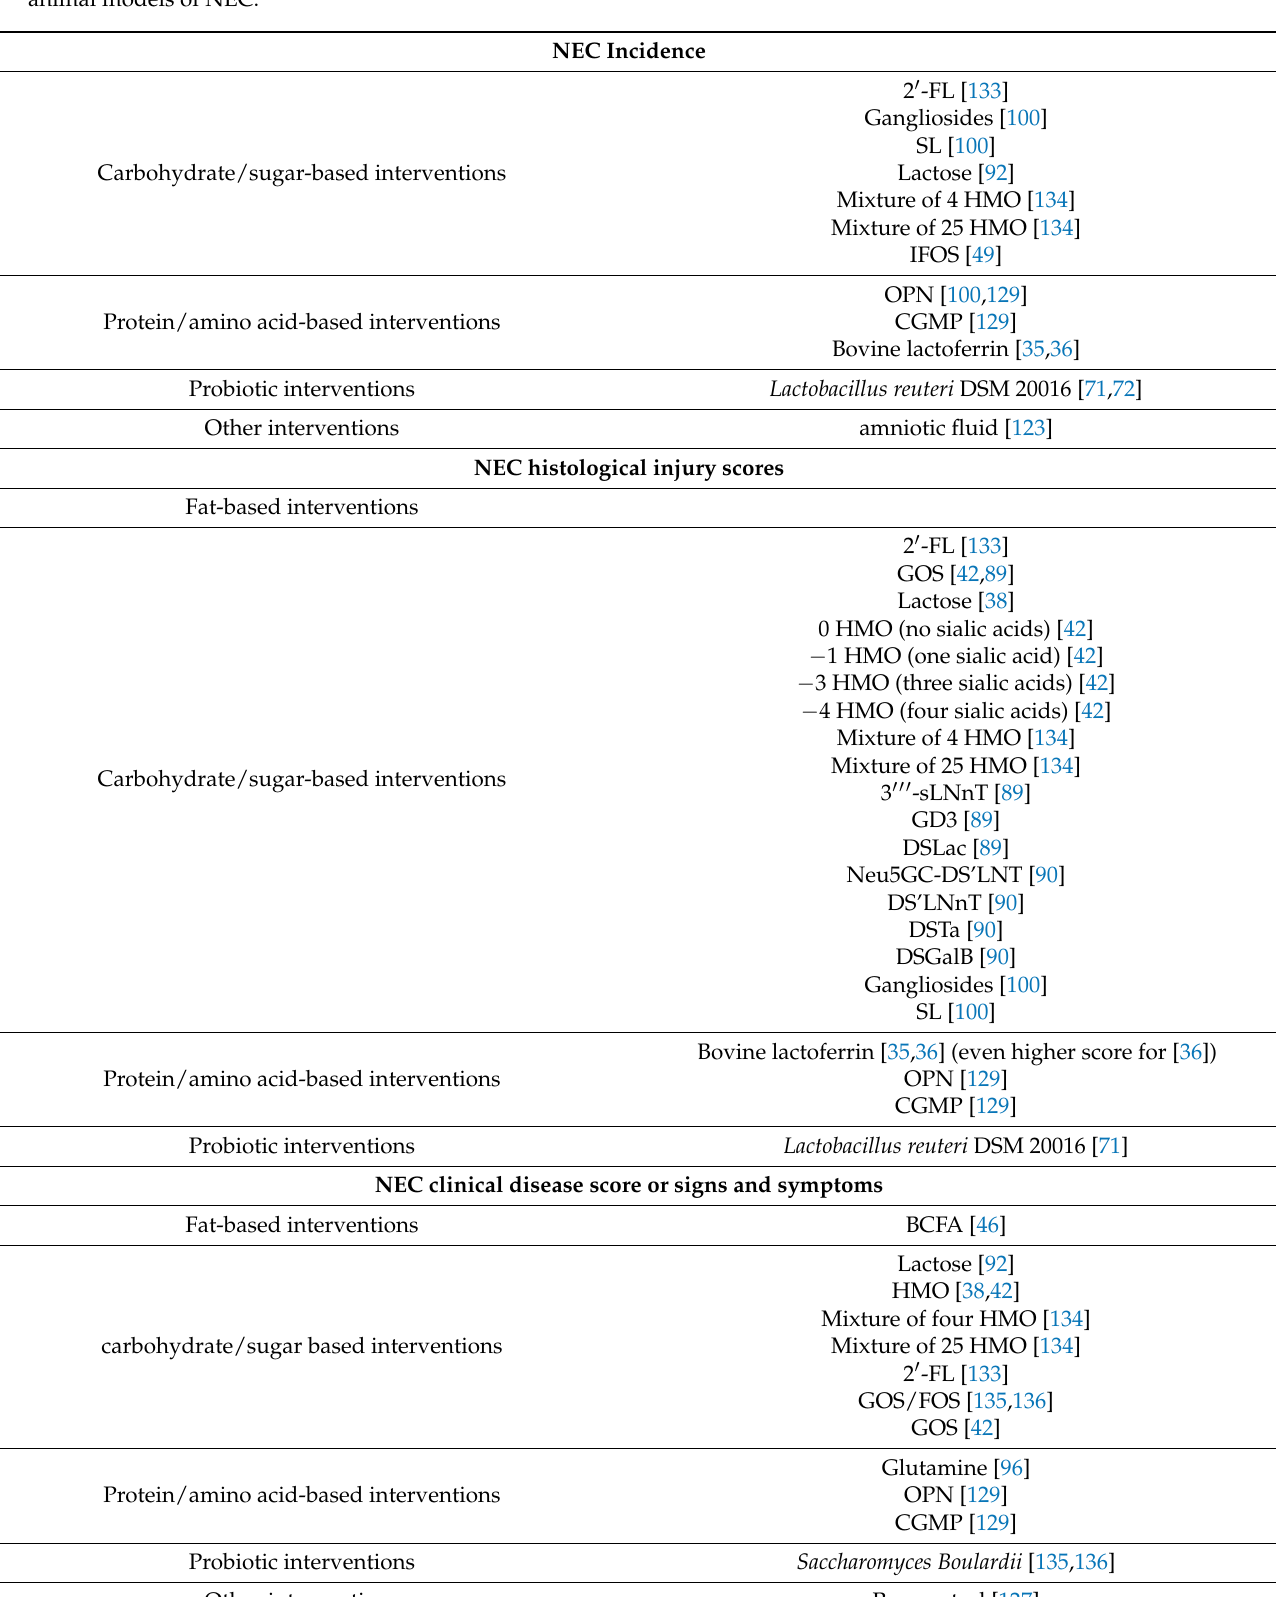
Table 5. Overview of studies that did not report statistically significant preventative effects of enteral feeding interventions on NEC incidence, histological injury scores, clinical disease scores or signs and symptoms or survival in experimental animal models of